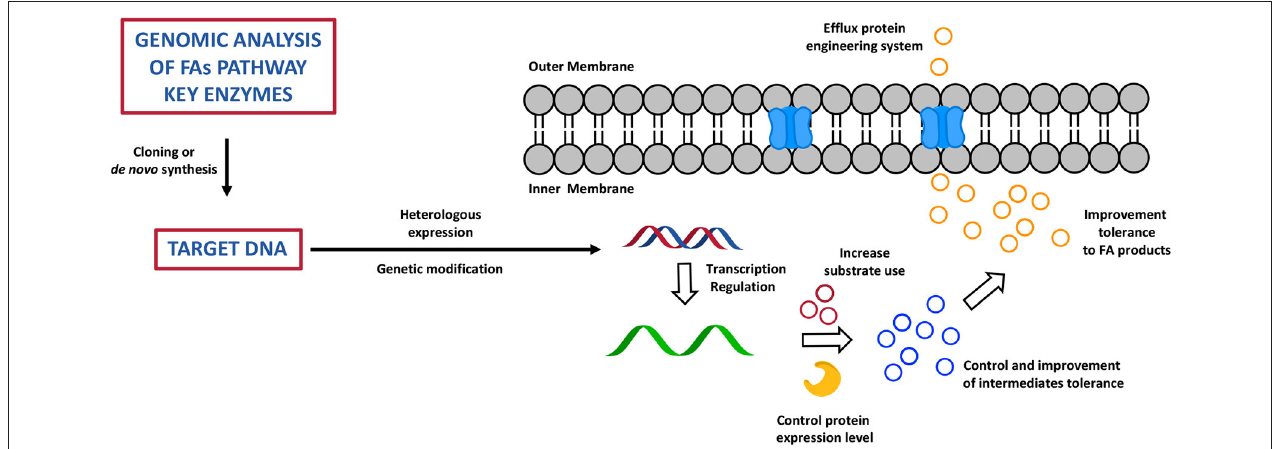
FIGURE 6 | The cartoon represents the most important step of the bioengineering process of cell factory to produce high valuable fatty acid products. This has been adapted from Yu et al. (